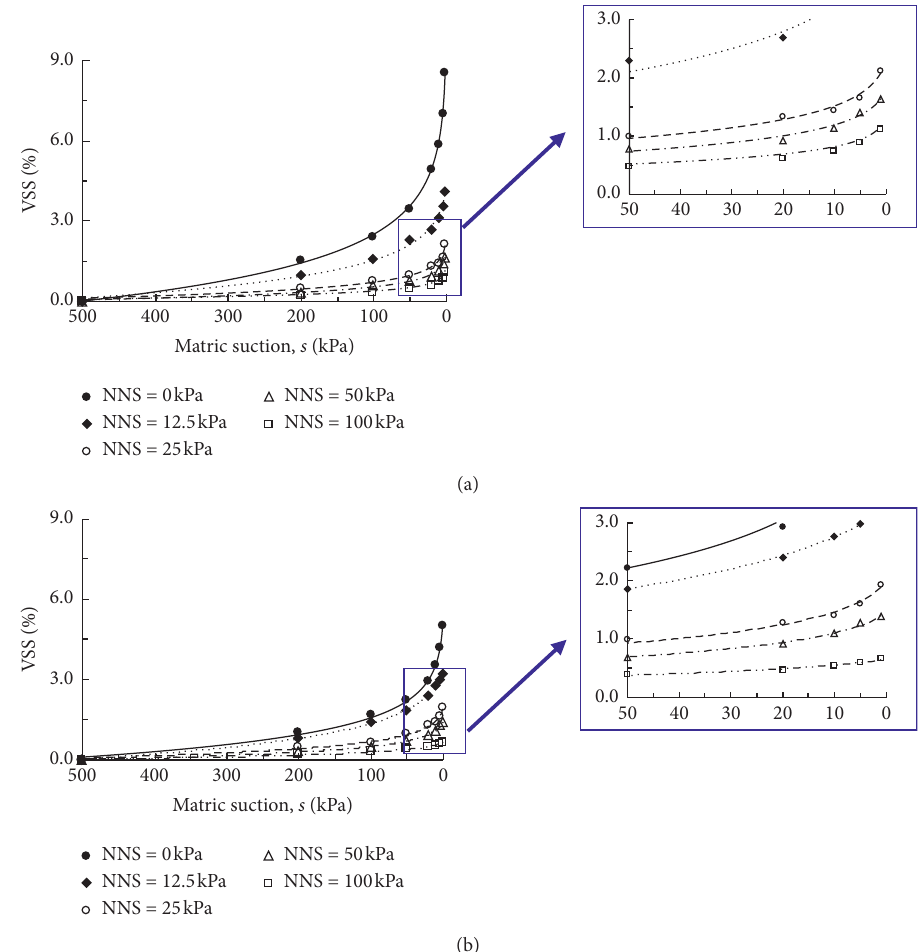
Figure 6: Variation of VSS under different NNS with matric suction in (a) VS test and (b) LS